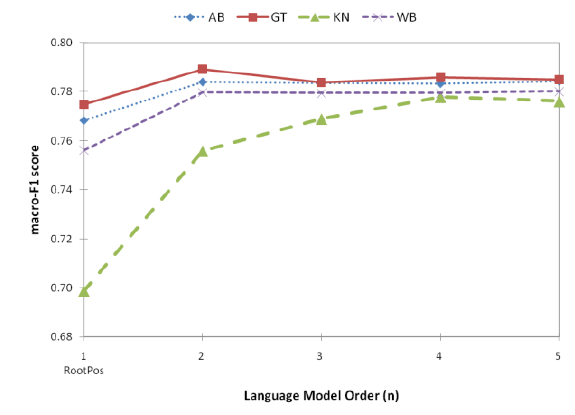
Fig. 3. Performance of root based language models with different smoothing methods with respect to language model order